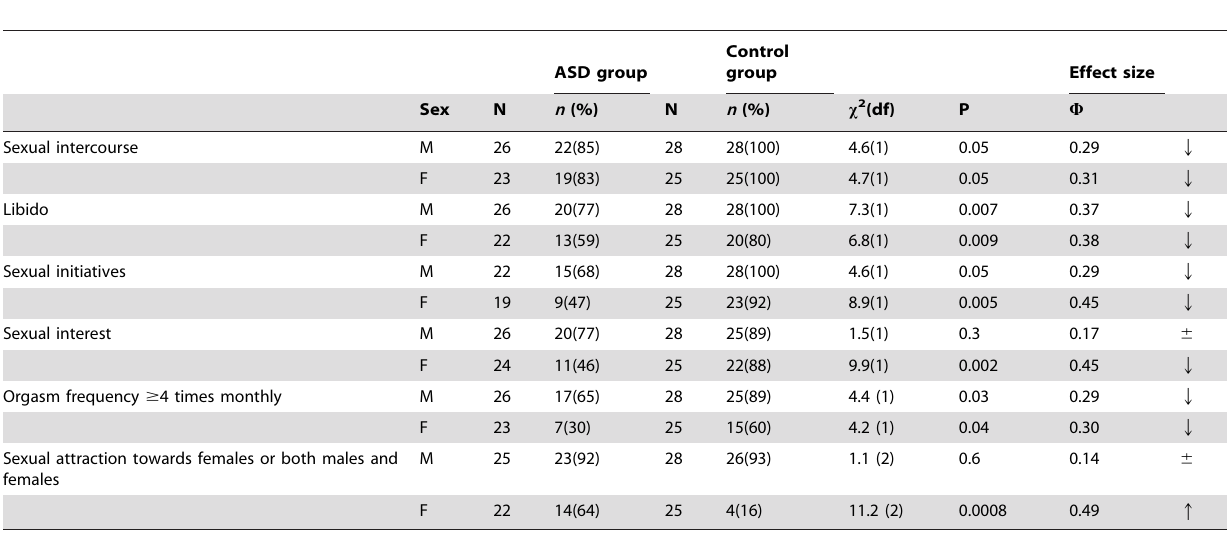
Table 5. Sexuality parameters; q denotes an increase and Q a decrease in masculine sexuality in autism spectrum disorder (ASD) compared with controls.